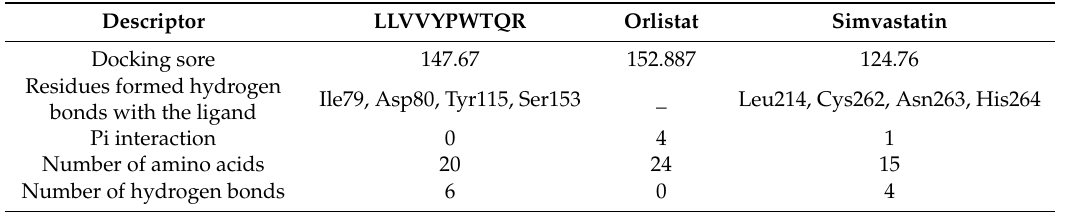
Table 4. Detailed view of the docked pose of the corresponding interacting amino acids within the binding site of pancreatic lipase enzyme (PDB